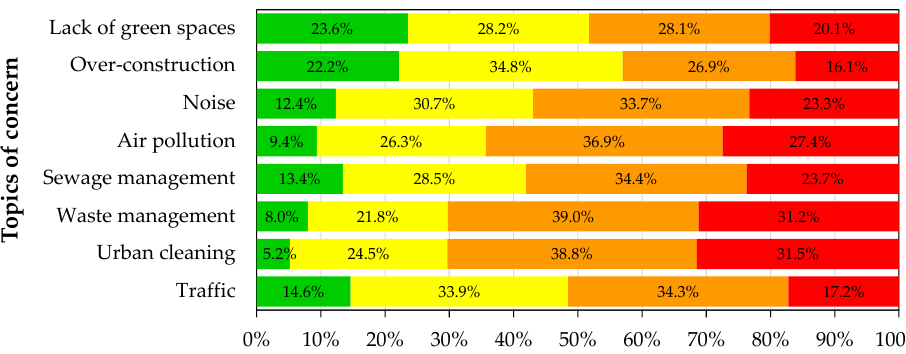
Figure 2. Level of concern of the general population regarding different environmental topics.